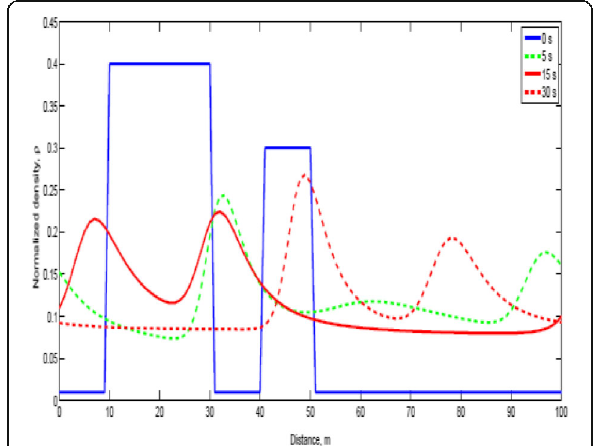
Fig. 1 The KG model density behavior with τ = 1 s